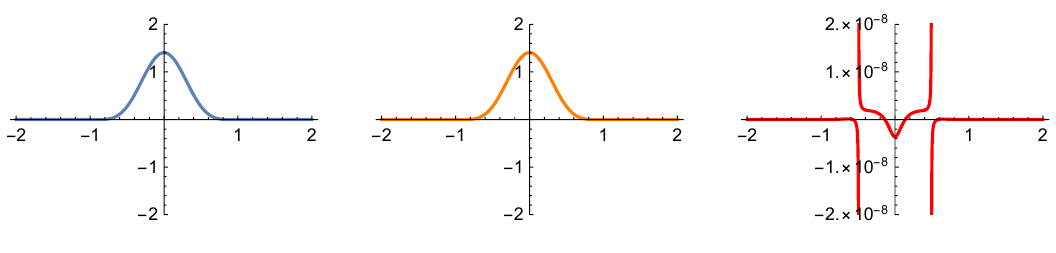
Figure 20. N = 3 Baxter solution q ( (cid:27) ) for the ground state (0 ; 0) at ! 1 = 1 p Left: numerical result; center: gauge theory result; right: